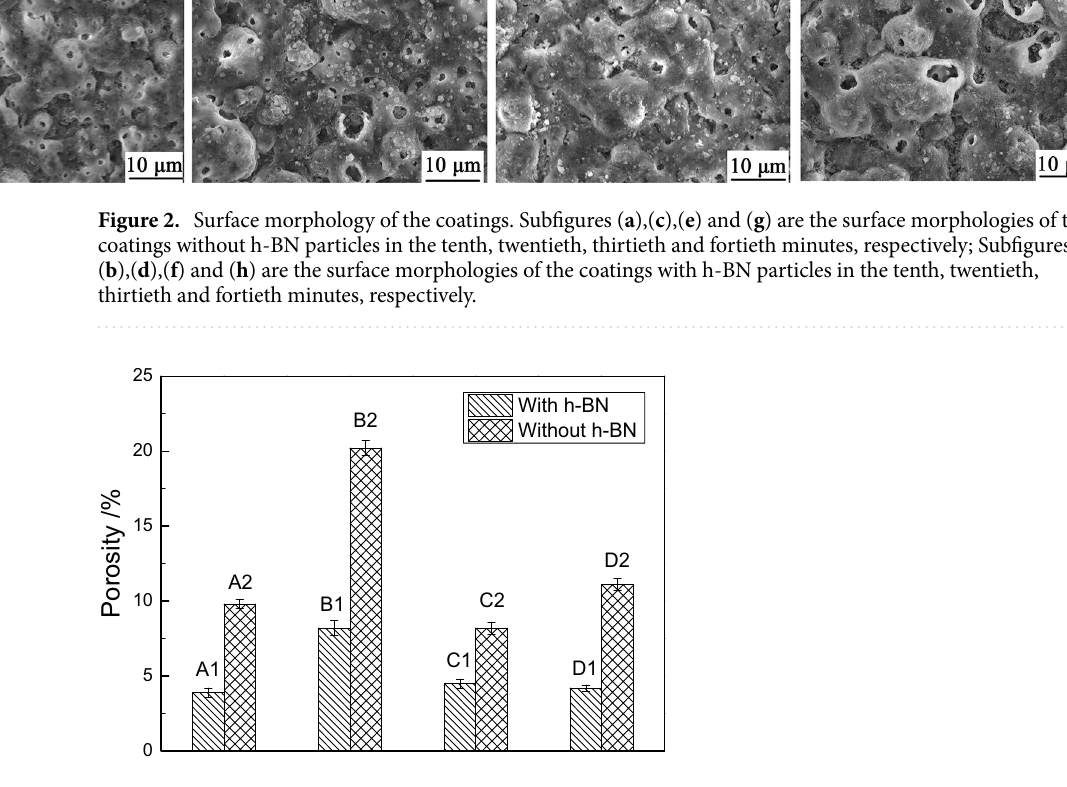
Figure 3. Porosity of the coatings with and without h-BN